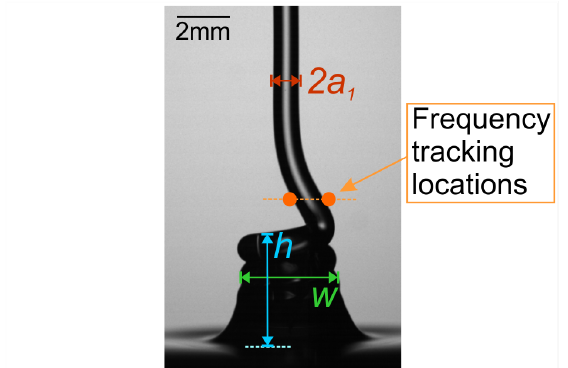
Figure 1. A general coil stack formed from falling honey. The measured dimensions include tail radius ( a 1 ), stack height ( h ), stack width ( w ), and coiling frequency ( Ω ). Highlighted areas show the tail and stack regions of interest where image-based measurements are